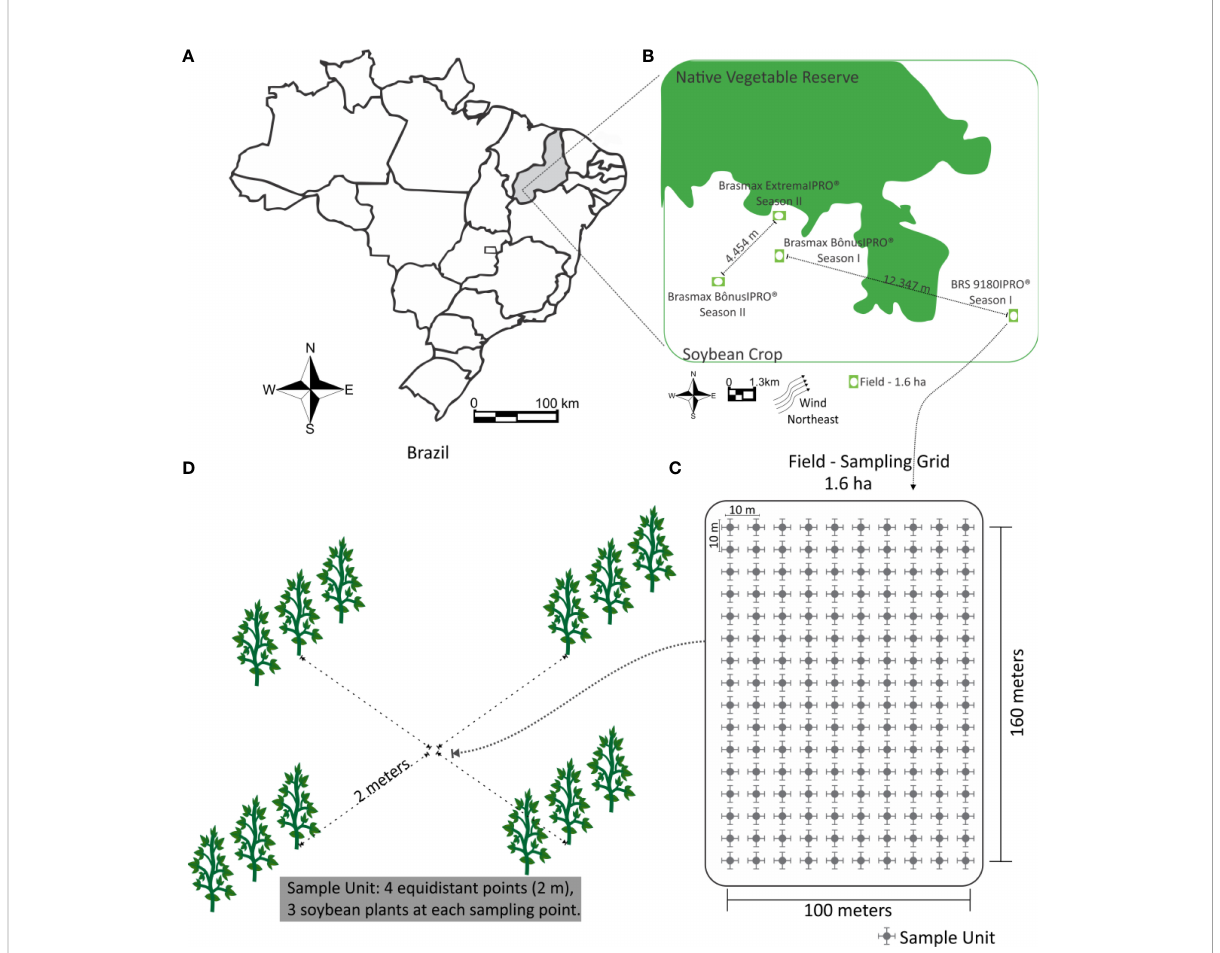
FIGURE 1 Location where the research was conducted (A) Brazil map showing Monte Alegre do Piau ı ́ , Piau ı ́ . (B) Location of fi eld within the area, the distance between each fi eld within an inside season. (C) Sample grid of the evaluated points and geographic location. (D) Sampling unit (3 plants equidistant from the central point, total of 12 plants per